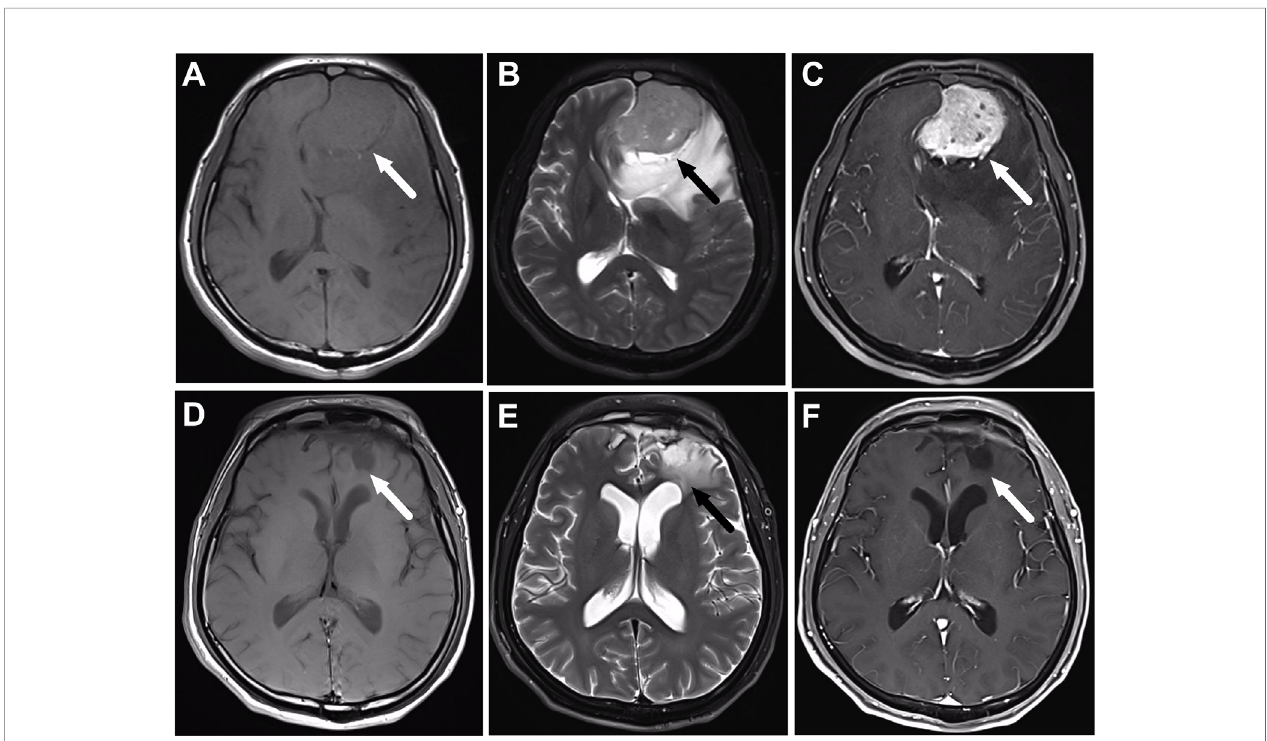
FIGURE 1 | A 56-year-old male patient with olfactory neuroblastoma of Kadish Stage C underwent surgical resection followed by chemoradiotherapy. (A – C) are the magnetic resonance (MR) images before treatment, while (D – F) are the corresponding MR images after the completion of treatment. (A) Axial T1-weighted MR imaging reveals an isointense mass in the frontal lobe (arrow). The mass has moderate signal intensity on T2-weighted MR images (B) , and shows heterogeneous enhancement on the post-contrast T1-weighted MR images (C) . (D – F) show that the tumor totally disappears after the completion of treatment, and there is still edema of the frontal lobe